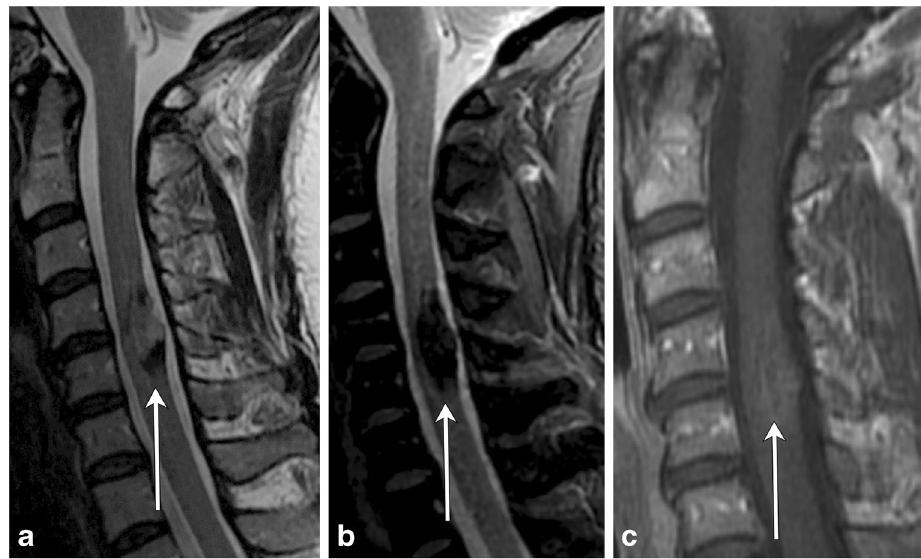
Fig. 21 Cavernoma. A 40-year- old female with left upper ex- tremity numbness. a Sagittal T2 image shows a short segment mixed signal lesion and layering oflow signalatthe inferior aspect. b The lesion is hypointense on the sagittal GRE image. c Sagittal T1 post-contrast image shows mini- mal strands of